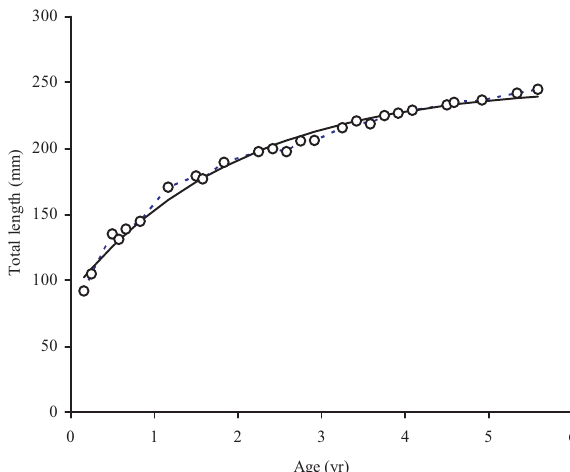
F IG . 4. – Standard (solid line) and seasonal (dashed line) von Berta- lanffy growth curves fitted to monthly mean length-at-age data (open circles), for round sardinella in the Aegean Sea.